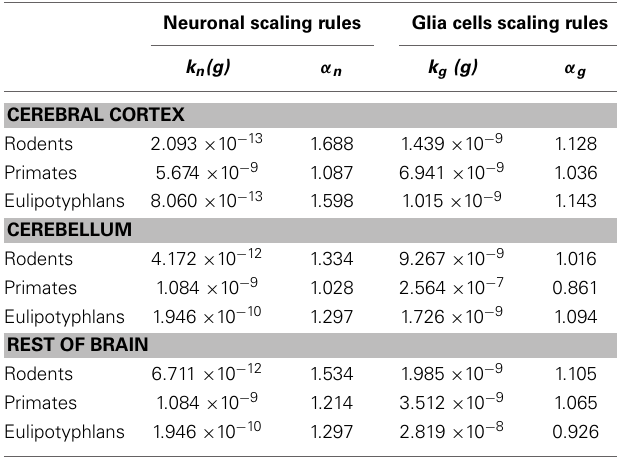
Table 1 | Constants and exponents for neuronal and non-neuronal scaling